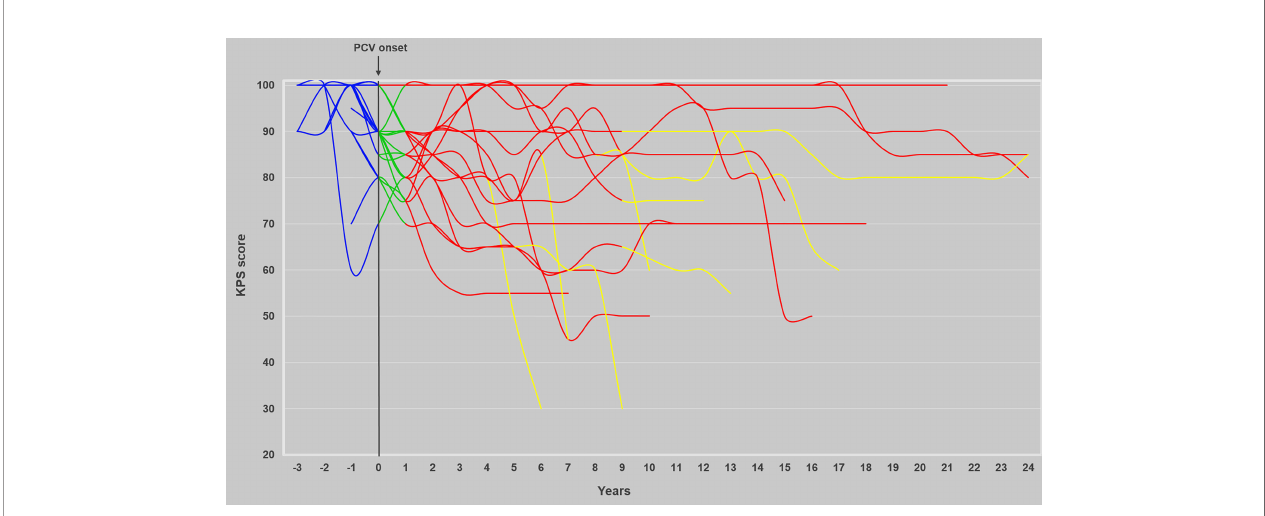
FIGURE 4 | Evolution of KPS over time before, during, and after the sequence PCV followed by RT. The evolution of KPS ( n = 20) before, during, and after the combined treatment and at progression is represented in blue, green, red, and yellow,